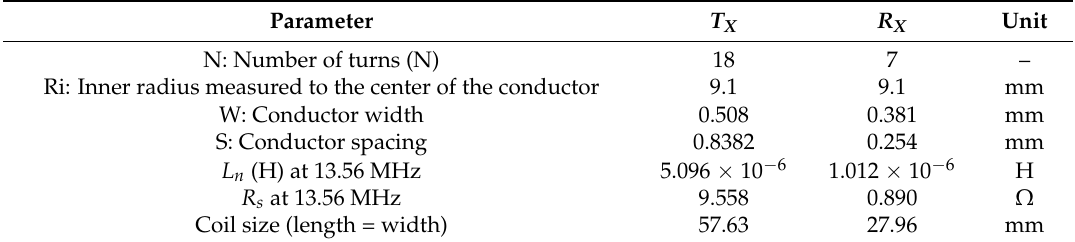
Figure 12. Coils optimization results using ADS momentum. ( a ) T X coil; ( b ) R X coil. Table 7. Parameters of the optimal geometry of the two coils using ADS